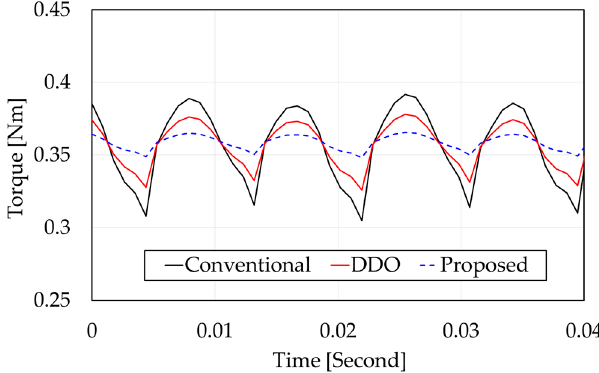
Figure 9. Torque ripple characteristic comparison.